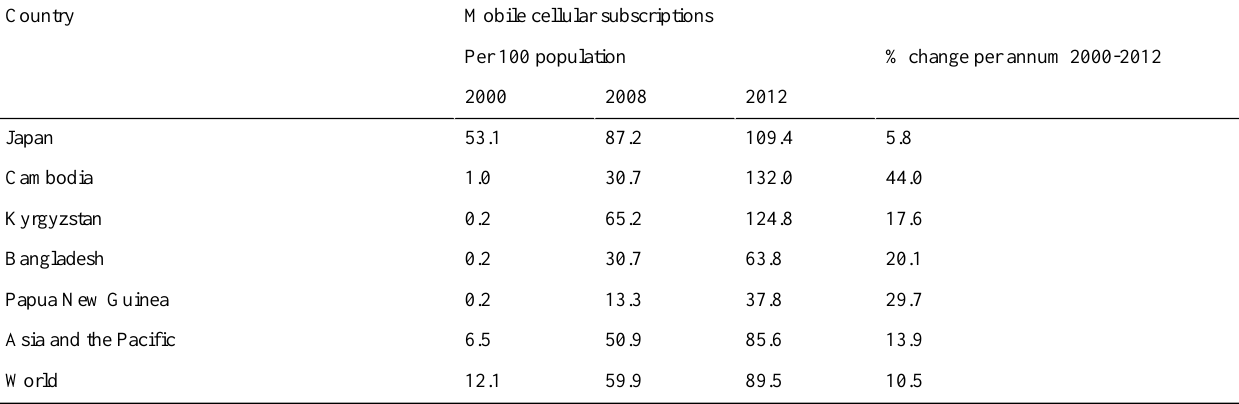
Table 1. Asia and the pacific mobile cellular subscriptions in 2000, 2008, and 2012. a